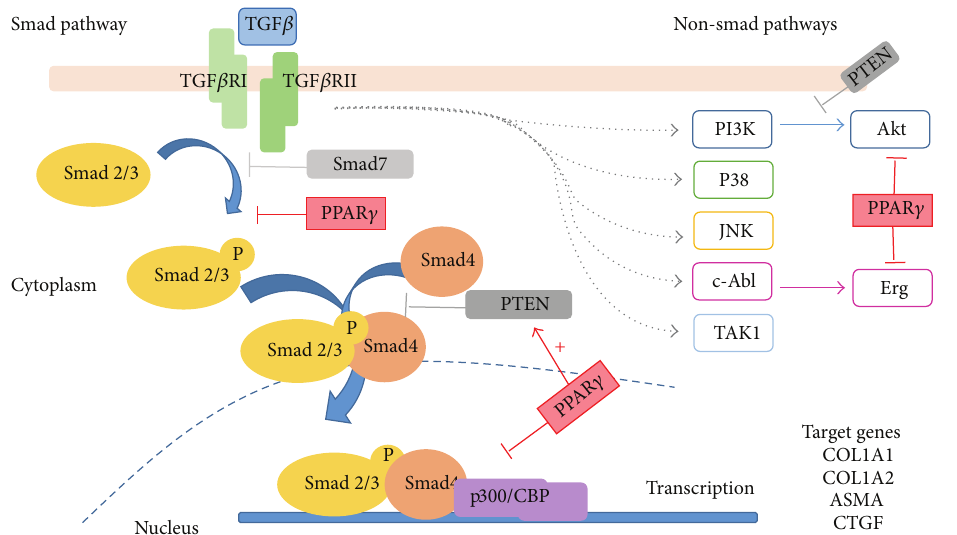
Figure 2: Smad and non-Smad signaling TGF- 𝛽 pathways and potential effects of PPAR 𝛾 ligands. Binding of TGF- 𝛽 to type 2 TGF- 𝛽 receptor (TGF- 𝛽 RII) recruits type 1 TGF- 𝛽 receptors (TGF- 𝛽 RI), forming a heterotetrameric structure that phosphorylates Smad2 and Smad3, which then binds to Smad4. Smad complex then translocates to the nucleus, where it interacts with various transcription factors to regulate the transcription of target genes (COL1A1, COL1A2, ASMA, CTGF). After TGF- 𝛽 binding, TGF- 𝛽 RII recruits a TGF- 𝛽 RI and activates it by phosphorylation. Nonclassic pathways are also illustrated. PPAR 𝛾 ligands can block TGF- 𝛽 signaling by blocking Smad and non-Smad